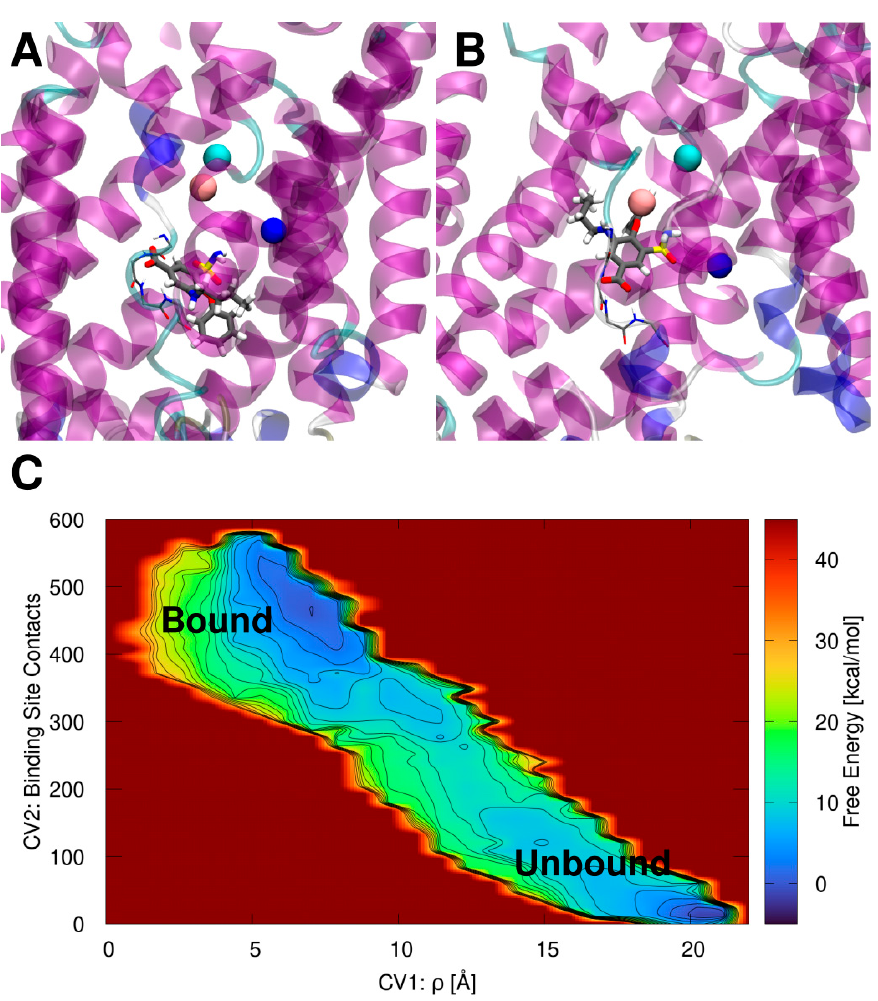
Figure 2. ( A ) Bumetanide (BUM) binding pose inside the zebrafish (z)NKCC1 structure as obtained from docking simulation. ( B ) BUM binding pose inside zNKCC1 as obtained from metadynamics simulation. NKCC1 is depicted as as magenta, blue, cyan, and white new cartoons for α -helix, 3 10 -helix, turn and coil elements, respectively. The Cl − , Na + , and K + ions are shown as cyan, blue, and orange van der Waals spheres, respectively. The BUM is shown in licorice and colored by atom name. The (empty) bCl − binding site is shown as thin licorice for visual reference. ( C ) Free energy surface (kcal/mol) of the BUM binding/dissociation extracted from the volume-based metadynamics simulation of the ion-bound (holo) zNKCC1. The free energy is plotted as a function of the ligand center of mass with respect to the center of mass of the protein CV1 ρ (Å) and the number of contacts of BUM with its binding site (CV2). Free energy is reported in color ranging from dark blue to dark red. Contour lines are reported every 2.0 kcal/mol.